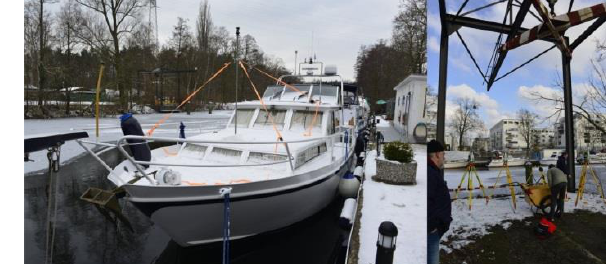
Figure 8: The equipped ship (left) as well as the applied sensors (right) on the opposite bank of the ship